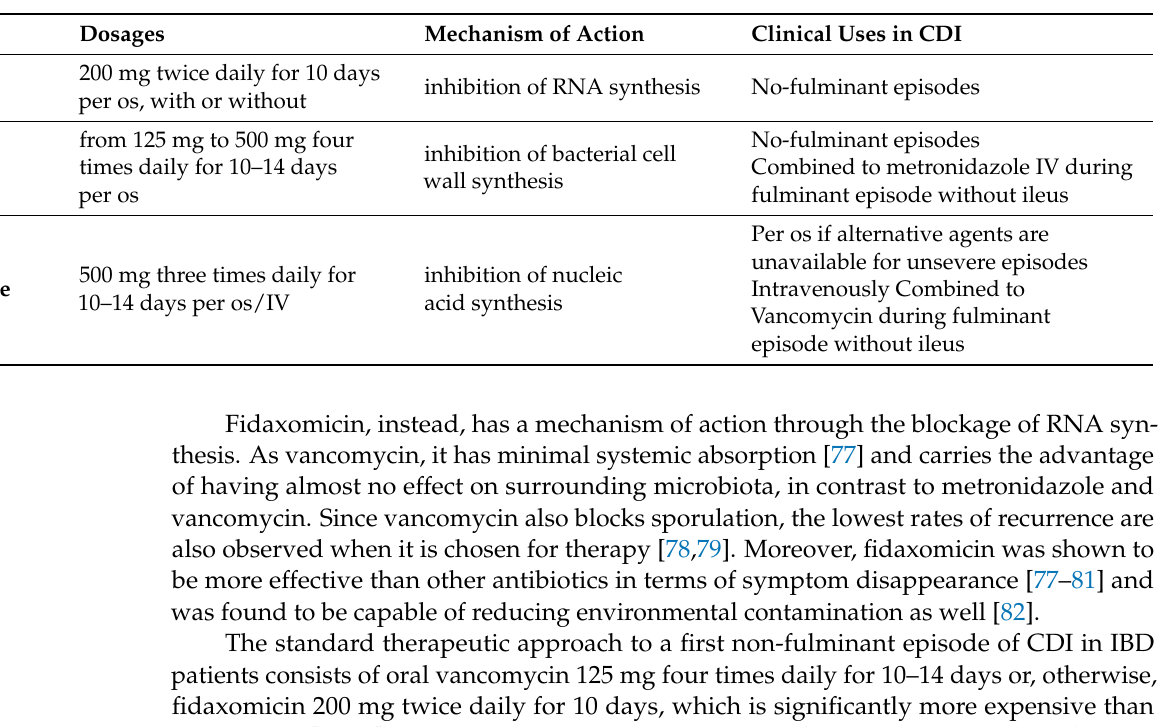
Table 3. Dosages, mechanism of action, and clinical uses of the three antibiotics approved for CDI in IBD.